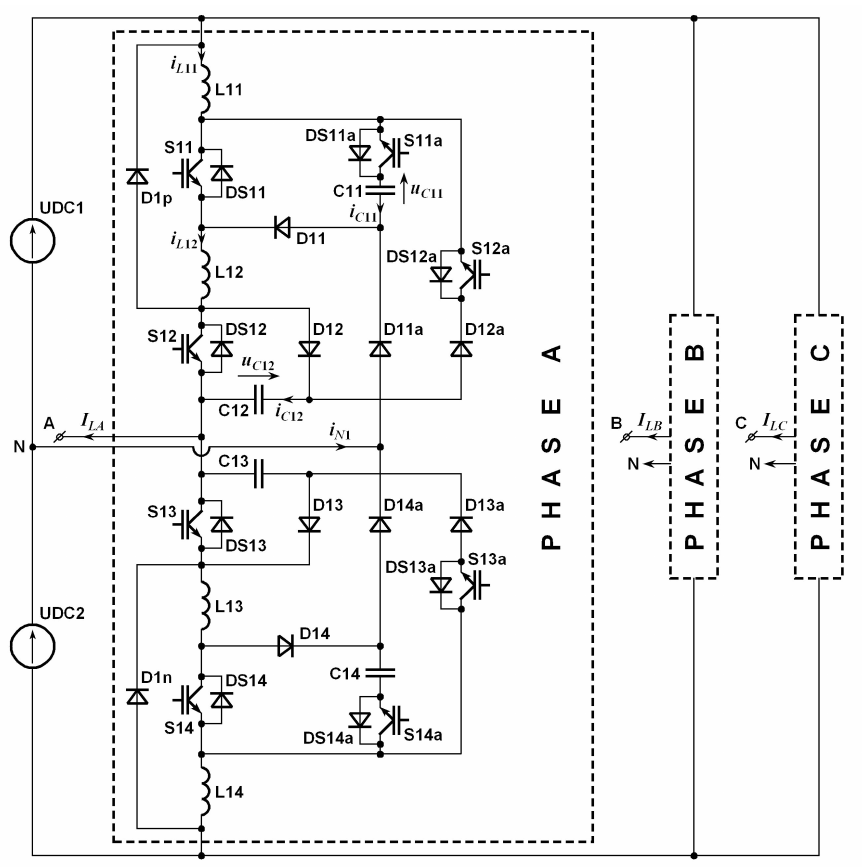
Figure 1. One phase of a three-phase three-level neutral-point-clamped (3LNPC) inverter with the proposed soft-switching system; A, B, C—load terminals; N—neutral